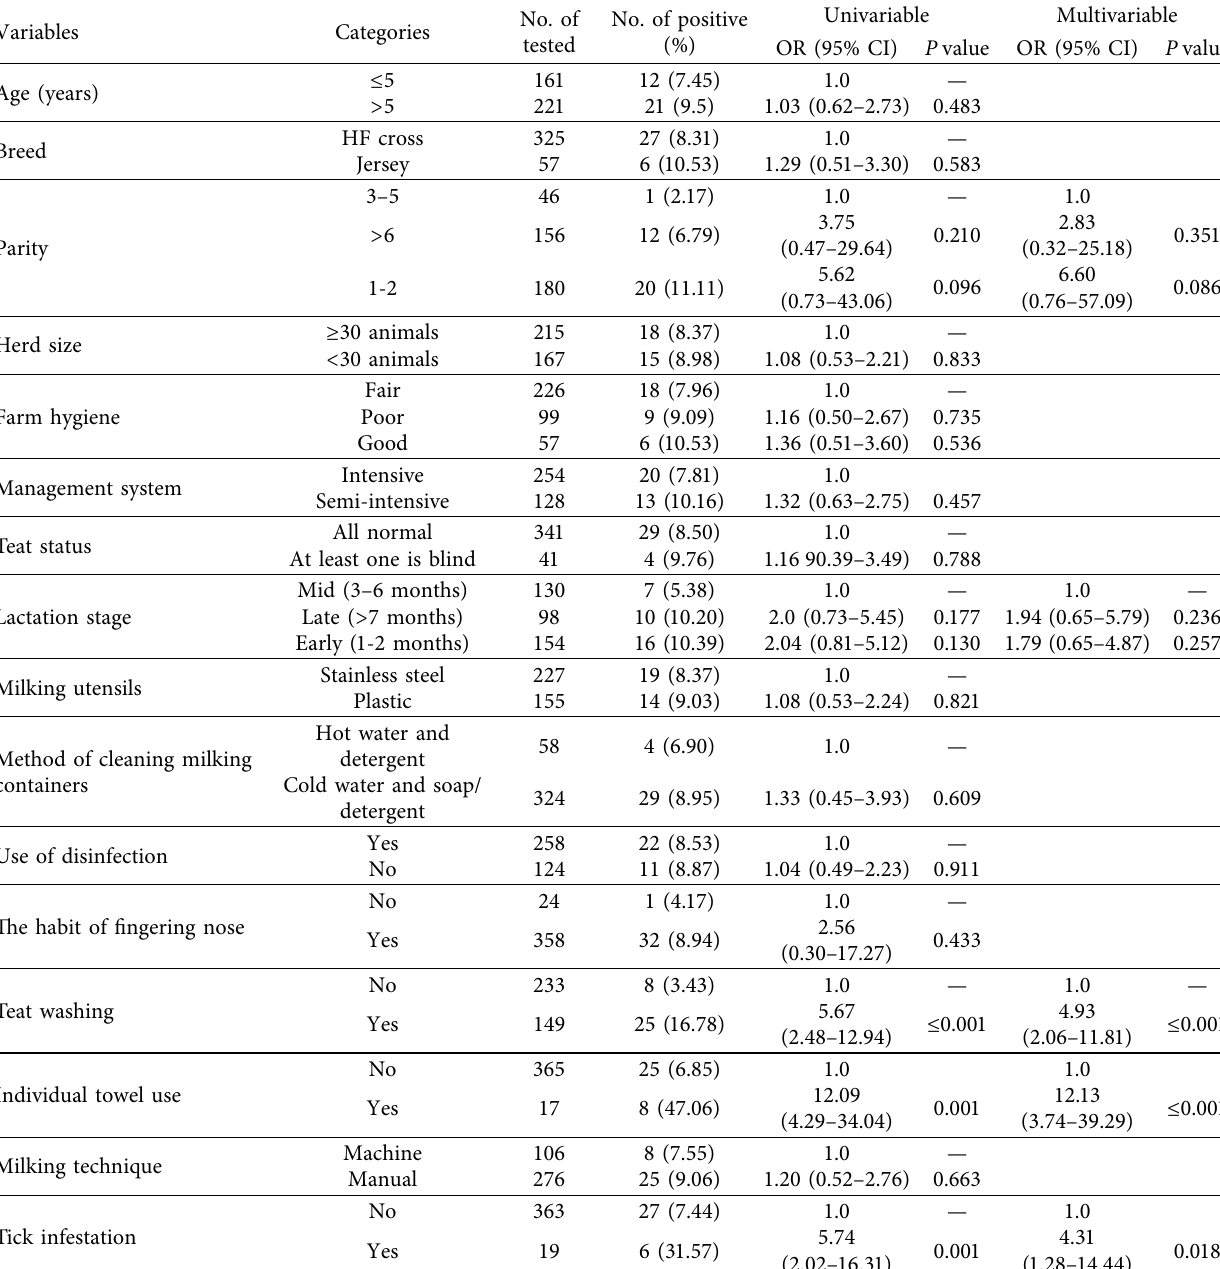
Table 5: Results of logistic regression analysis of potential risk factors associated with the prevalence of Staphylococcus aureus in raw milk.